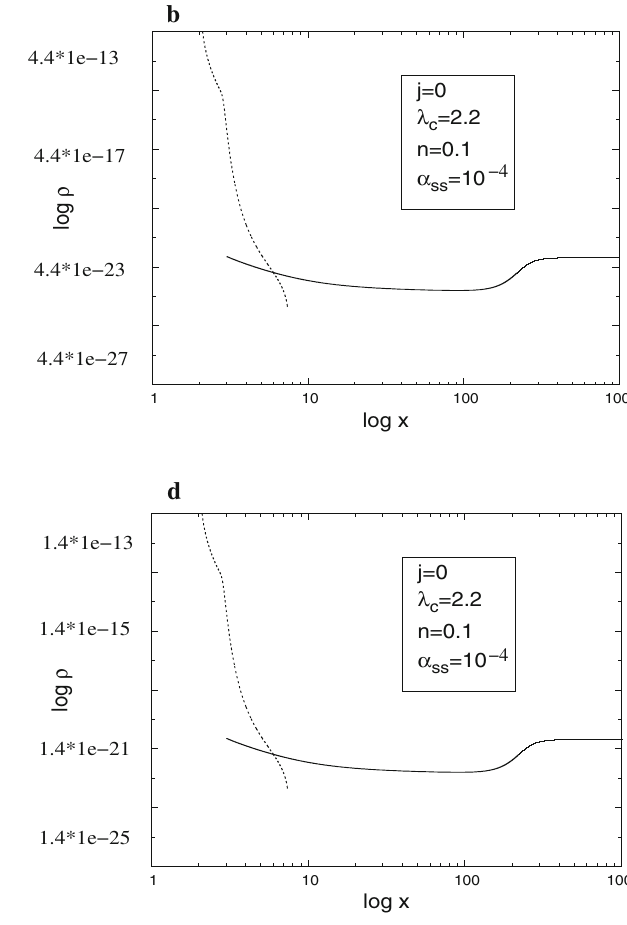
tion disc flow with viscosity α ss = 10 − 4 , around a non-rotating BH for MCG using NFW and Einasto profile respectively. Accretion and wind curves are depicted by solid and dotted lines